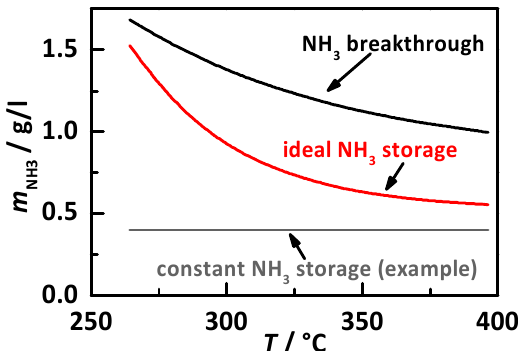
Figure 3. Illustration of the investigated approaches for NH 3 target storage with percentage gradation of the storage degree when first NH 3 breakthrough occurs (black) and of the ideal NH 3 storage curve (red, minimum storage for maximum NO x conversion), both determined in stationary experiments in Ref. [20], and different constant storage levels between 0.2 and 1.4 g/l cat in a gradation of 0.2 g/l cat (example of 0.4 g/l cat displayed in grey).